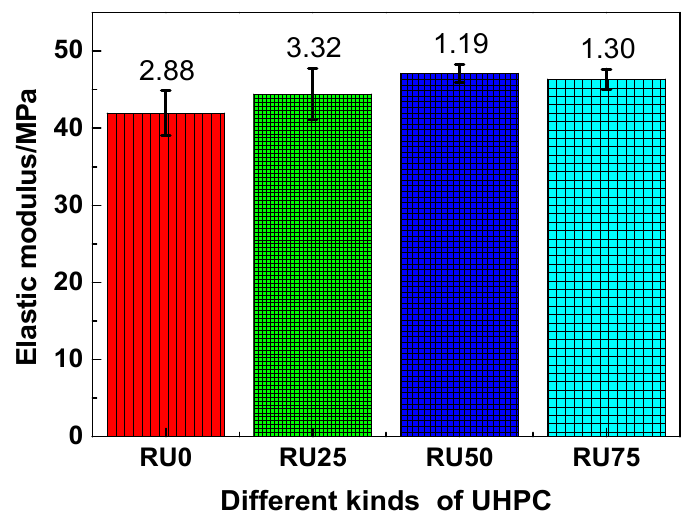
Figure 8. The elastic modulus of RS-UHPC with different contents of GO.